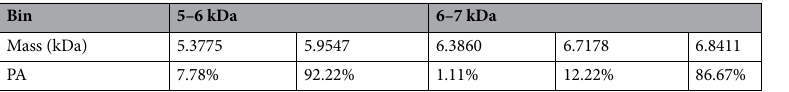
Table 2. The proportion of appearance (PA) of each peak in the spectral features data for the two bins which contained multiple peaks.